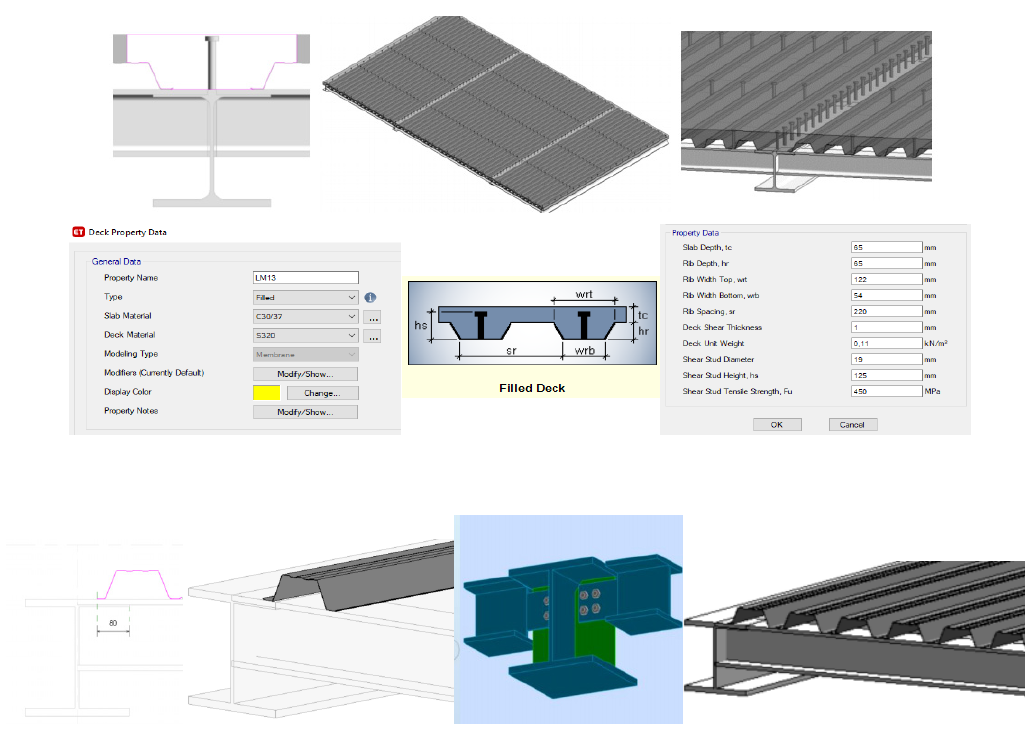
Figure 33. Modelling process of the composite slab.